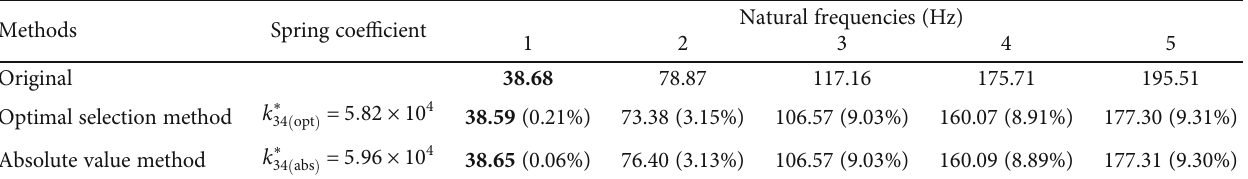
Table 7: Necessary spring coe ffi cient (N/m) and the natural frequencies.